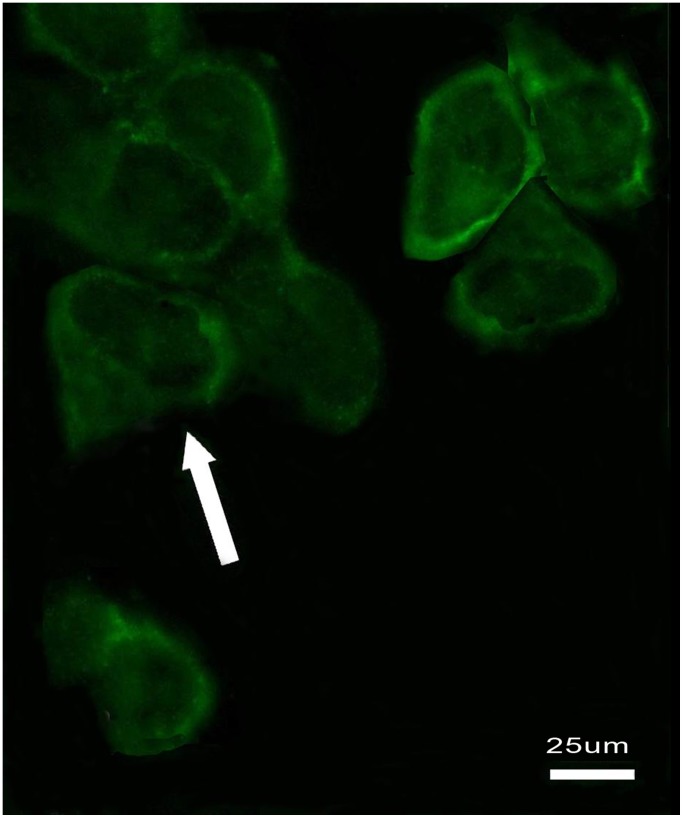
Immunofluorescence labeling was used to identify ICC-MY.c-Kit was expressed in ICC-MY, whose cell bodies and processes were obviously expressed. These cells interact and interwove with each other, whose shape was fusiform or triangular. Scale bars:25 µm.